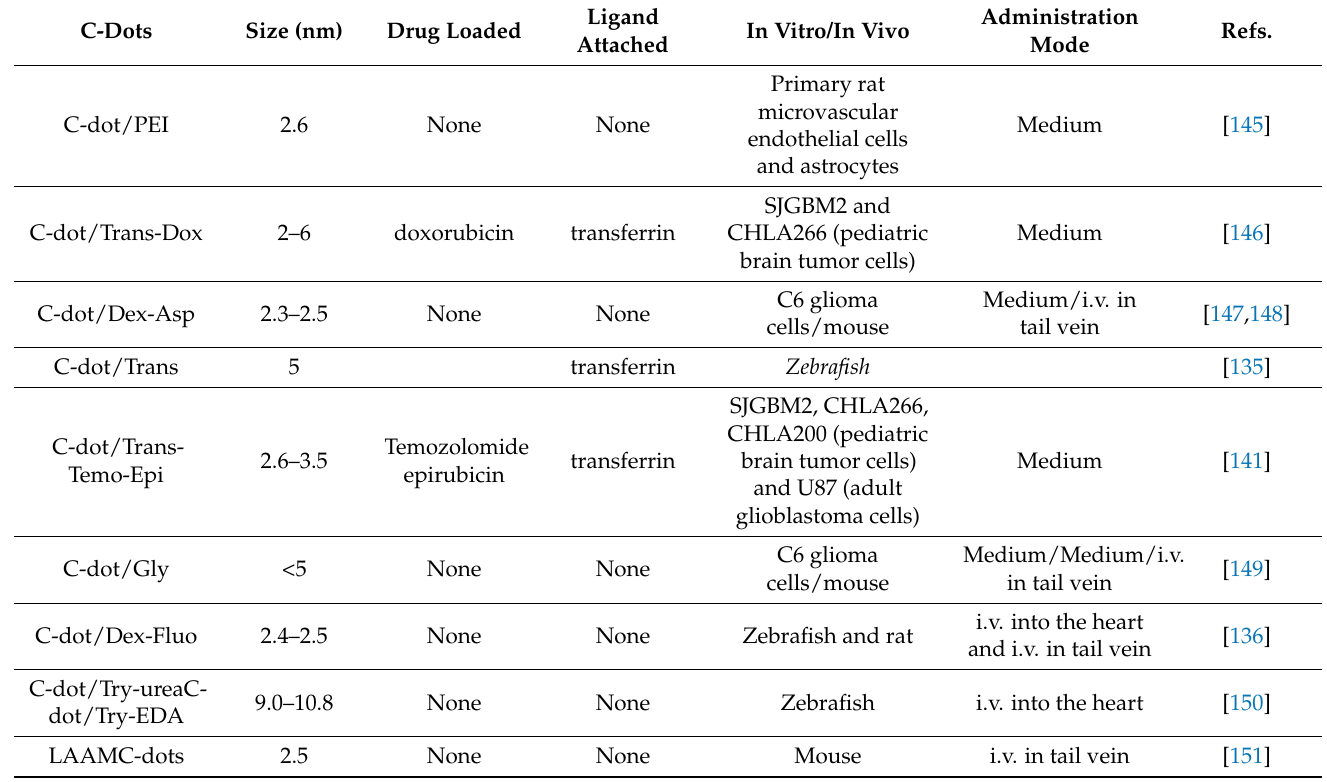
Table 2. Summary of C-dots-based drug delivery systems reported as being capable of crossing the BBB. Polyethyleneimine (PEI); Transferrin (Trans); Doxorubicin (Dox); Dextrose (Dex); L-aspartic acid (L-Asp); Temozolomide (Temo); Epirubicin (Epi); Glycine (Gly); Fluorescein (Fluo); Tryptophan (Try); 1,2-ethylenediamine (EDA); Large Amino Acid-Mimicking